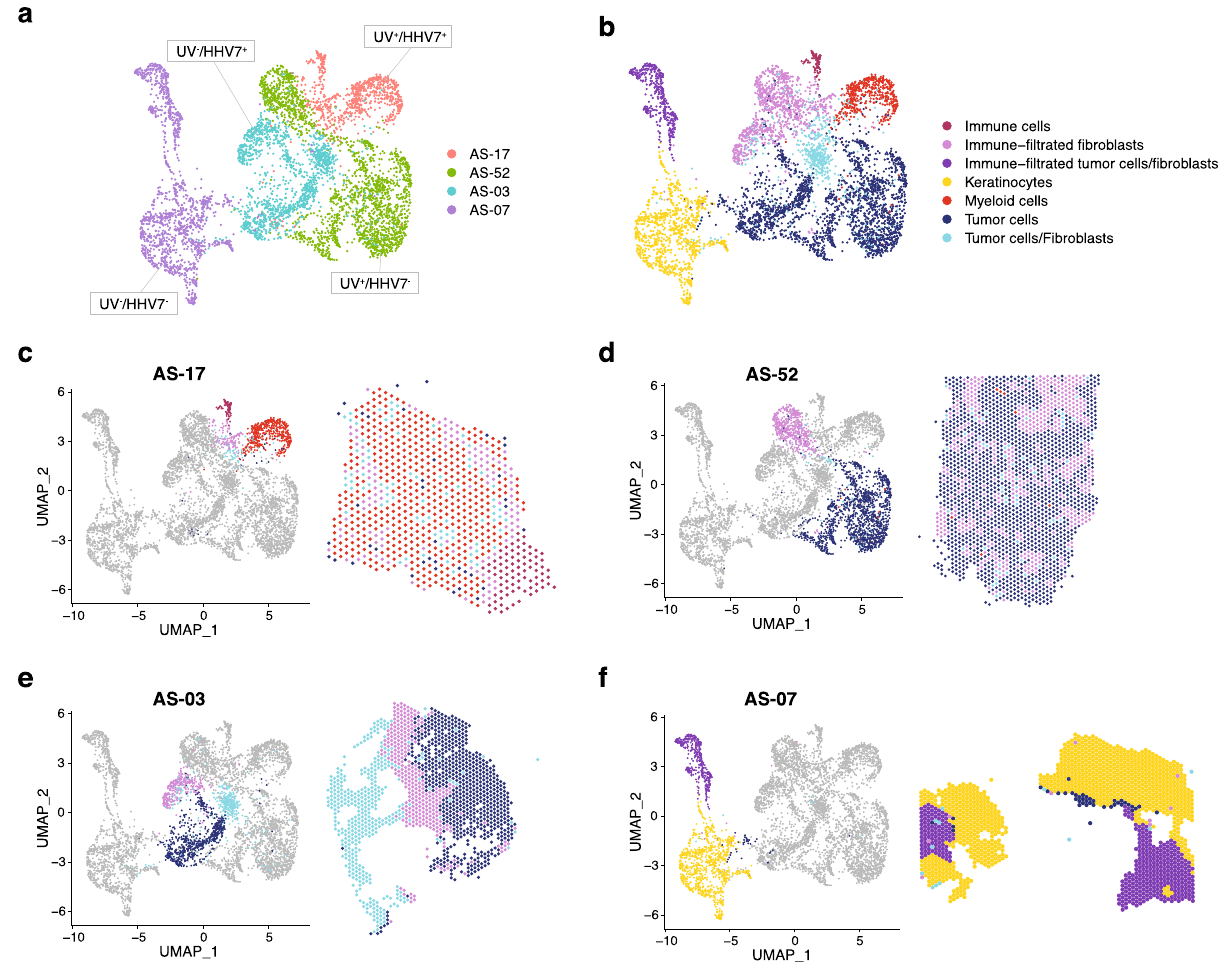
Fig. 4 Spatial transcriptomic pro fi ling of head and neck angiosarcomas representing four putative pathogenic etiologies. UMAP plots of merged spatial datasets showing ( a ) the distribution by samples (AS-17: UV-positive, HHV-7-positive, and immune hot; AS-52: UV-positive, HHV-7-negative, and immune intermediate; AS-03: UV-negative, HHV-7-positive, and immune intermediate; AS-07: UV-negative, HHV-7-negative, and immune cold) and ( b ) the distribution of seven clusters annotated with their predominant cell types. c – f Spatial projections of the UMAP spot transcriptome clusters onto their respective tissue sections revealed important information about the tumor